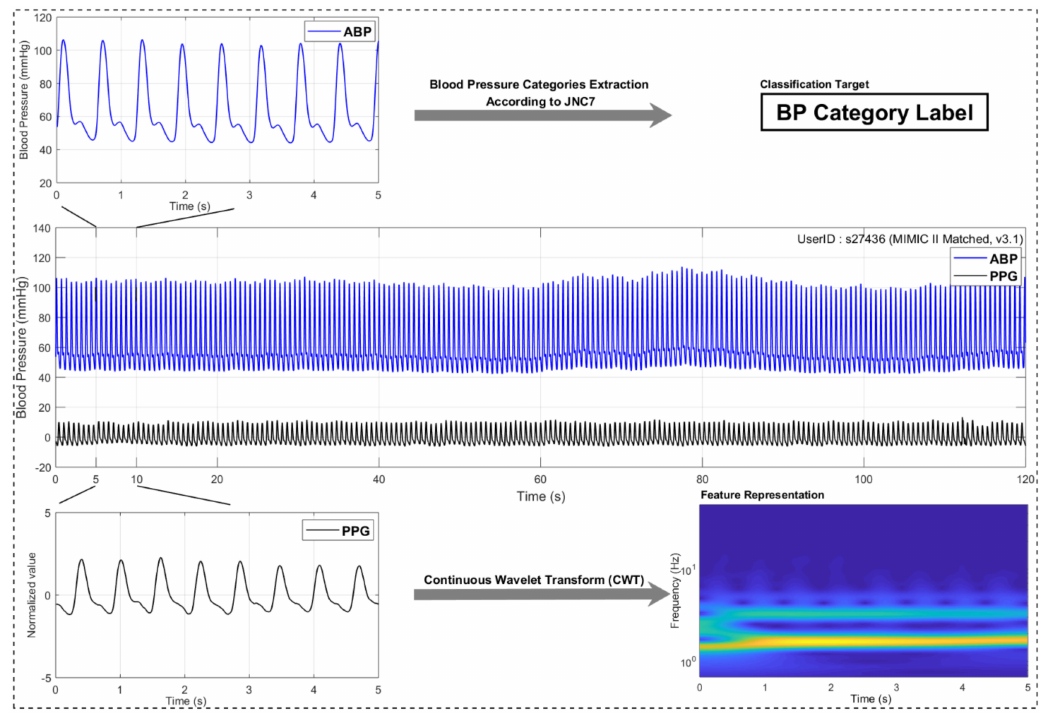
Figure 1. A signal processing structure. Note: PPG stands for photoplethysmogram , ECG stands for electrocardiogram , BP stands for blood pressure , and JNC7 stands for the Seventh Report of the Joint National